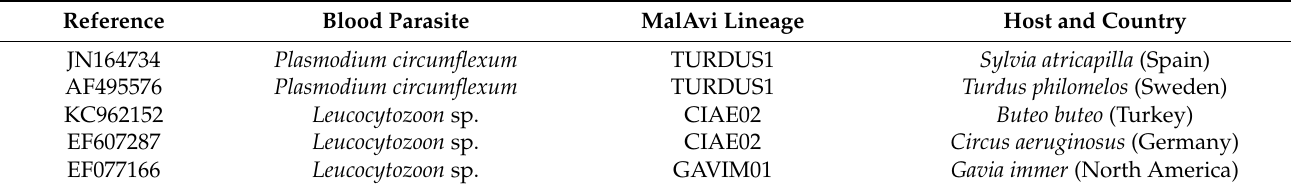
Table 2. Reference sequences included in the molecular phylogenetic